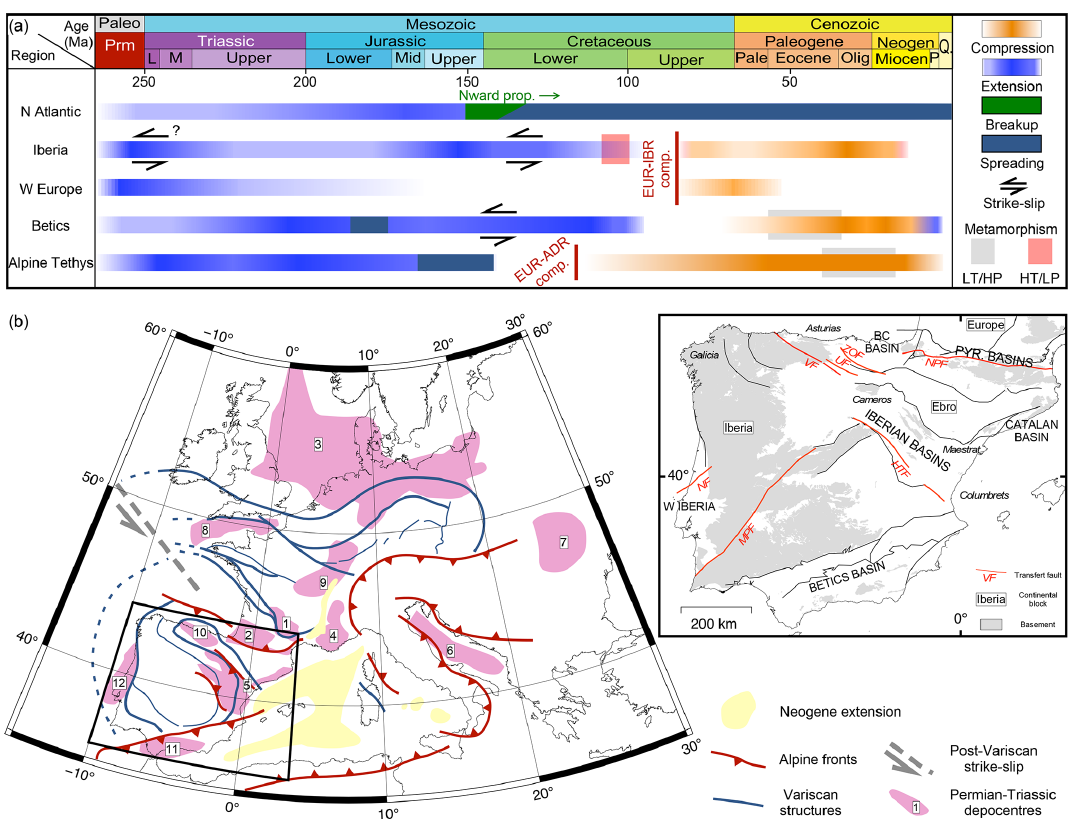
Figure 1. Geodynamic chart and localization of the study area. (a) Geodynamic chart of the main structural areas of the Iberian domain. (b) Location map of western Europe, showing the areas that are deformed in compression and extension and Permian–Triassic depocenters. (1) French Massif Central; (2) Aquitaine Basin and Pyrenees; (3) Germanic Basin; (4) southeastern France; (5) Iberian Basin; (6) Italy; (7) central Europe; (8) English Channel; (9) northeastern France; (10) Basque–Cantabrian Basin; (11) Betics; (12) West Iberia. Inset: Map of Iberia showing the main structures and transforms (red) and sedimentary basins (capitalized and italicized text) and sub-basins (italicized text). BC: Basque–Cantabrian; HTF: High Tagus Fault; MPF: Messejana–Plasencia Fault; NF: Nazaré Fault; NPF: North Pyrenean Fault; PYR: Pyrenean; UF: Ubierna Fault; VF: Ventaniella Fault; ZOF: Zamanza–Oña